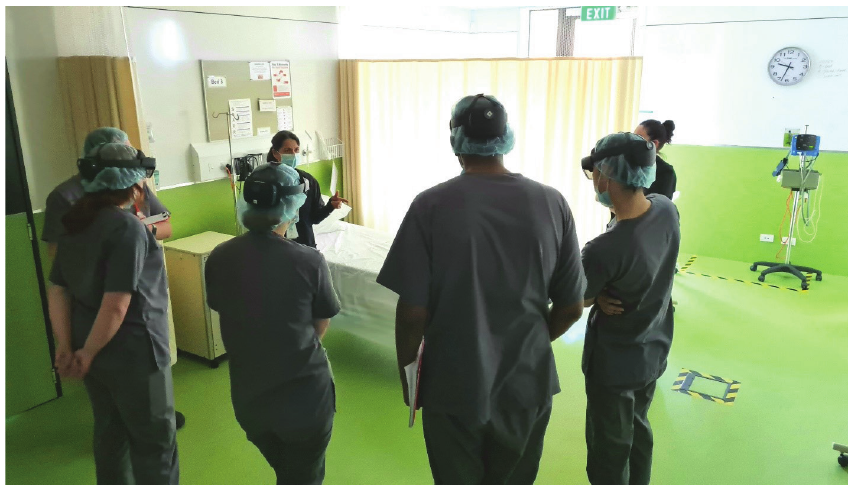
Figure 2. Students viewing a standardised holographic patient in clinic reasoning cycle training at Toi Ohomai / Te P ū